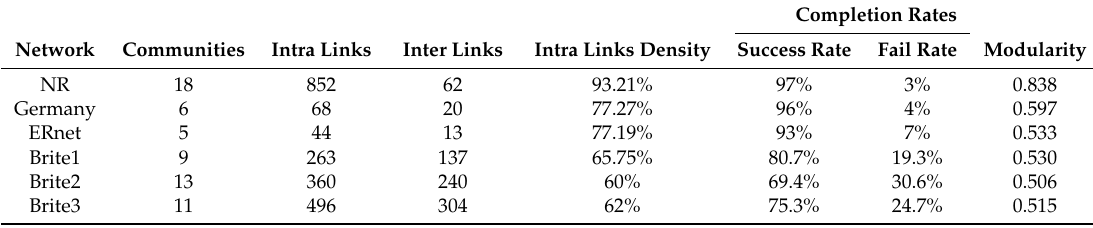
Table 3. Completion rate, link density and modularity achieved by Algorithm 3 for all